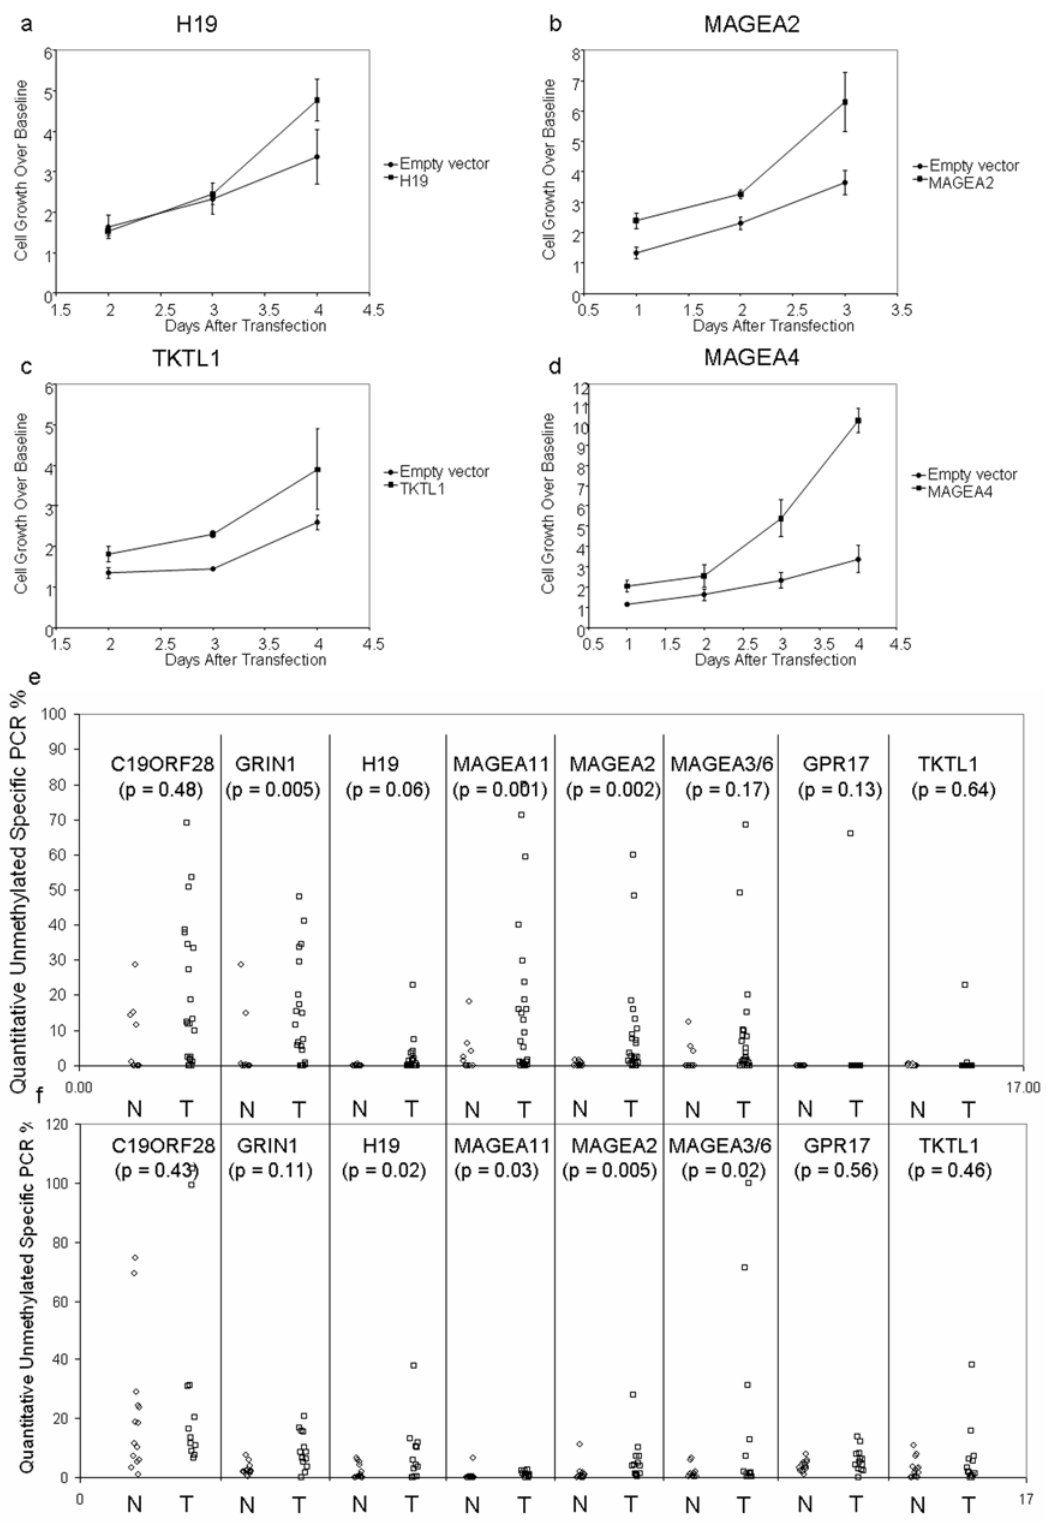
Figure 3. Transient transfection of target genes in minimally transformed oral keratinocytes. ( a ) Transient transfection of an H19 construct into OKF6-Tert-1R cells (at day 4, 41.4% 6 15% growth increase). ( b ) Transient transfection of an MAGEA2 construct into OKF6-Tert-1R cells (at day 3, 72.7% 6 26% growth increase). ( c ) Transient transfection of an TKTL1 construct into OKF6-Tert-1R cells(at day 4, 50.1% 6 38% growth increase). ( d ) Transient transfection of MAGEA4 construct into OKF6-Tert-1R cells (at day 4, 203% 6 17% growth increase). For ( e ) we developed a quantitative assay for measuring unmethylated promoters, termed Quantitative Unmethylation-Specific PCR (QUMSP). QUMSP percentage of C19ORF28 , GRIN1 , H19 , MAGEA11 , MAGEA2 , MAGEA3/6 , GPR17 , and TKTL1 was conducted in a separate cohort of head and neck cancer patients using